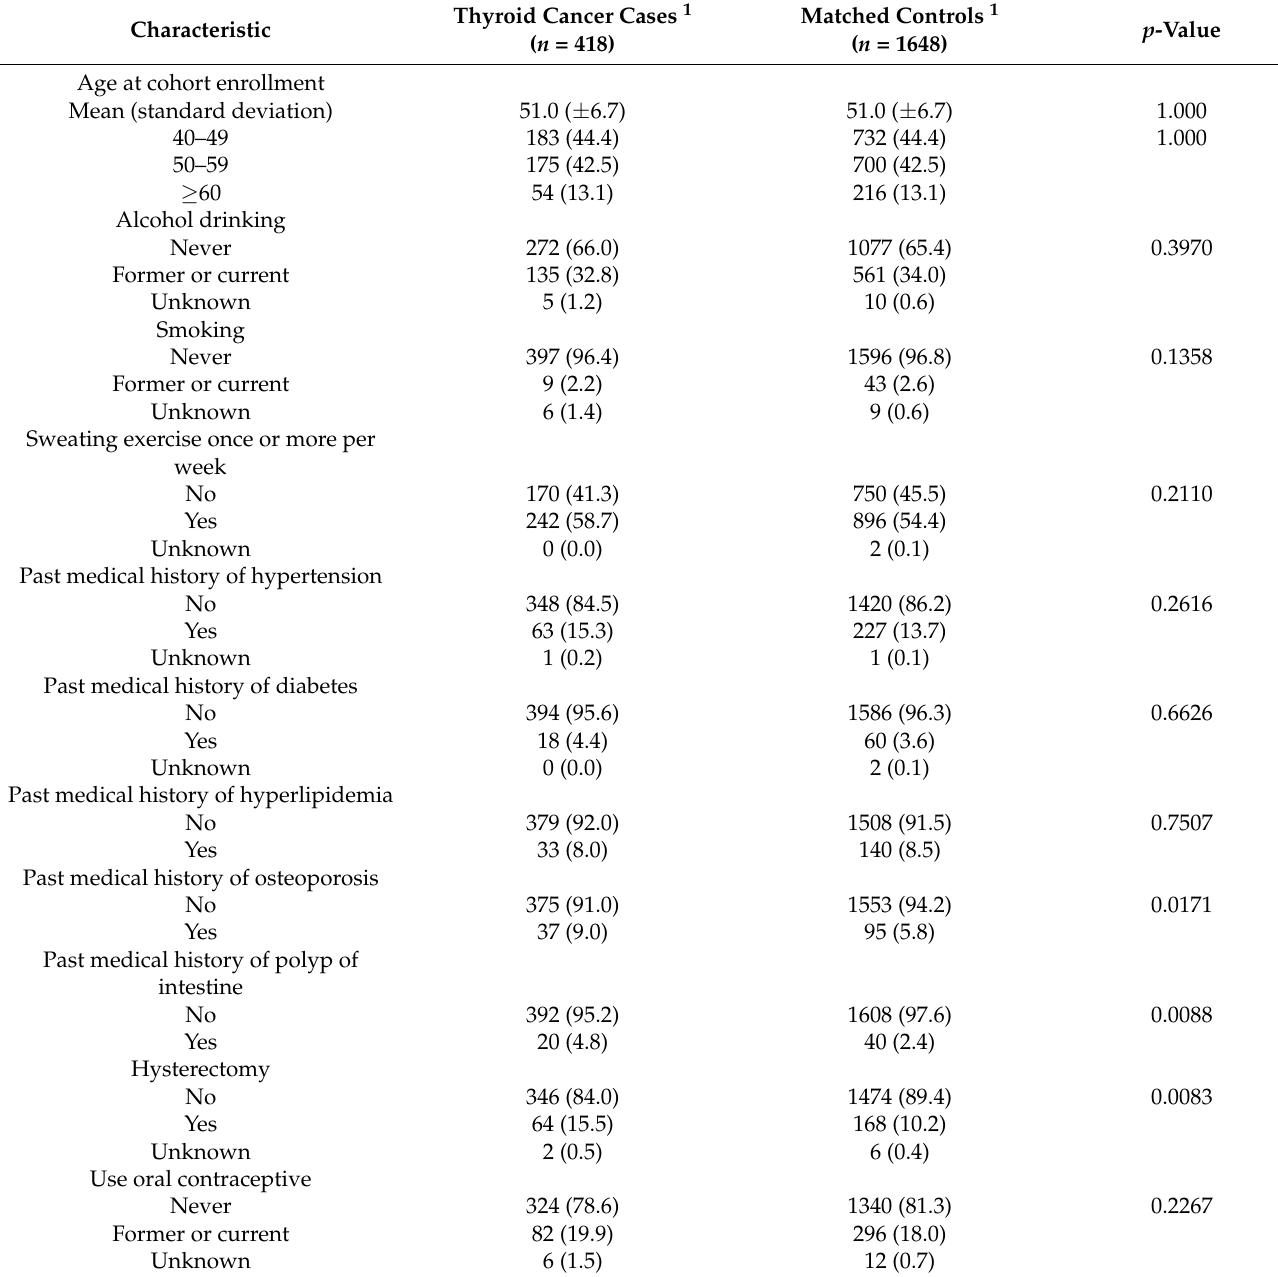
Table 1. Baseline characteristics of incident thyroid cancer patients and matched